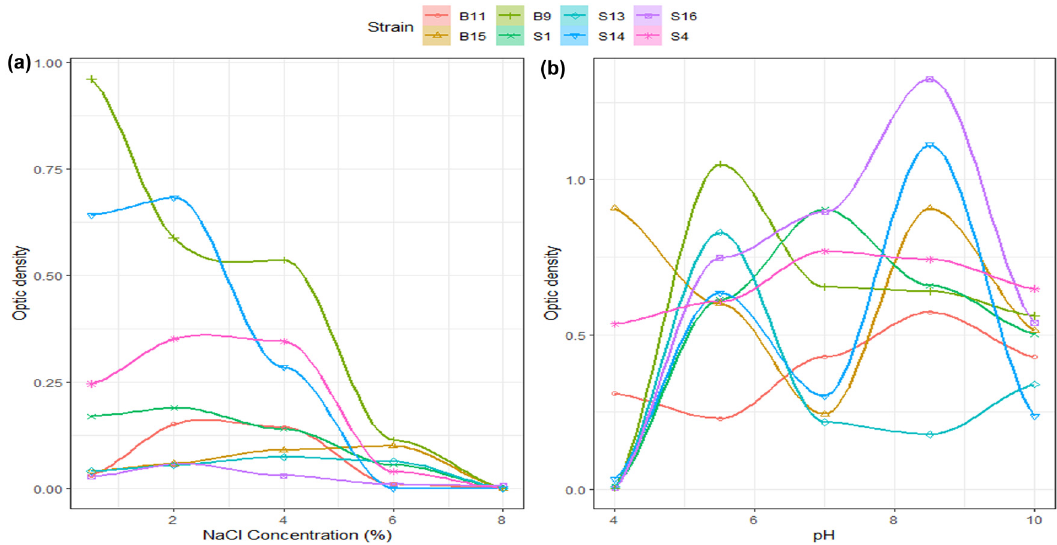
Figure 2: Growth of bacterial isolates as a function of NaCl concentration ( a ) and pH ( b )